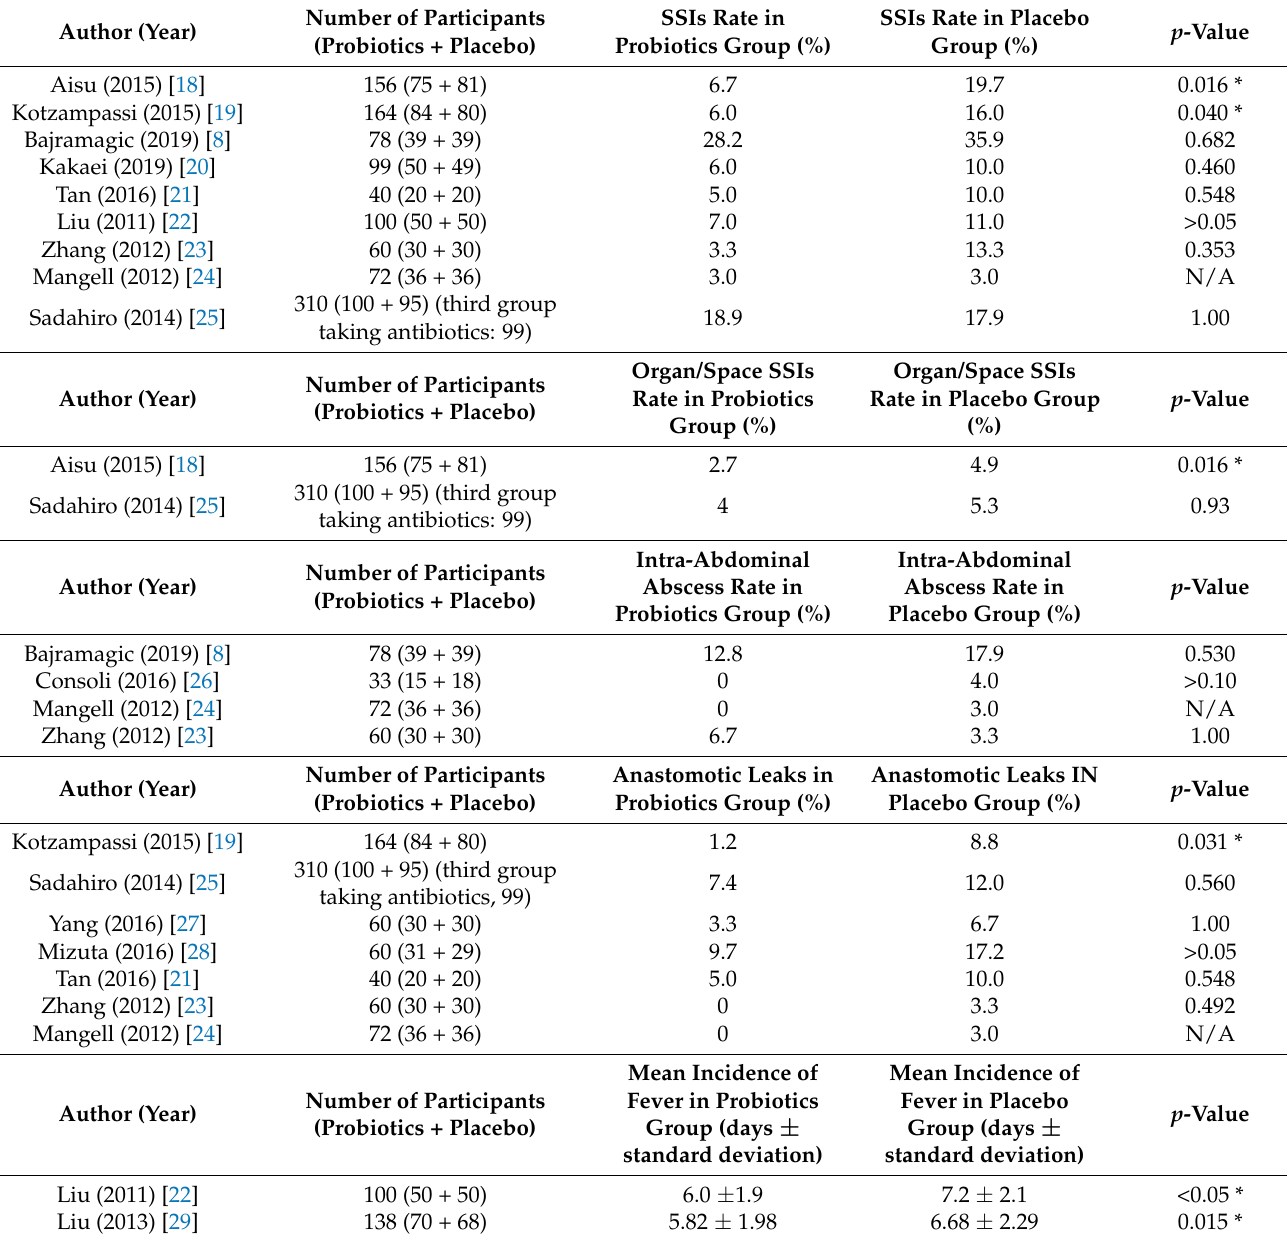
Table 2. Postoperative infectious complications